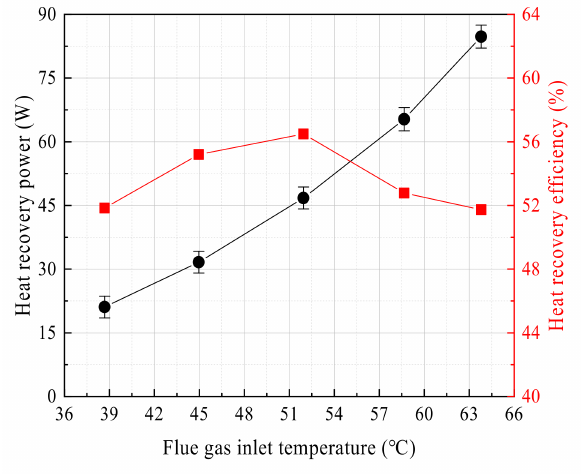
Figure 14. Heat recovery power/efficiency vs. flue gas temperature. Experiment conditions: flue gas flow 9.85 L/min, negative pressure airflow 15 L/min, negative pressure air inlet temperature 12.95 ◦ C, membrane pore size 10